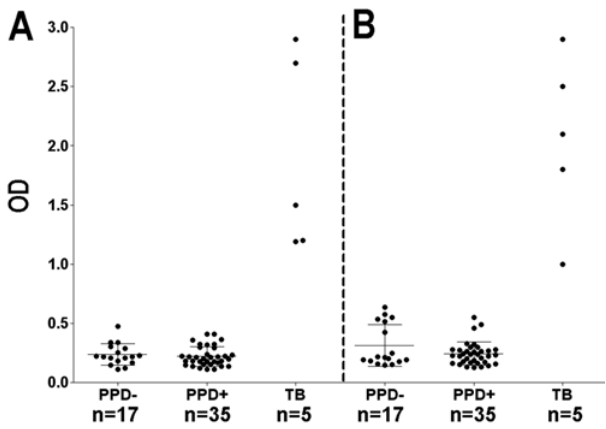
Figure 1. Reactivity of sera with MS and MPT51: Sera from HIV 2 PPD 2 and HIV 2 PPD + healthy subjects and TB patients were tested for reactivity with MS (A) and MPT51 (B). Mean OD (optical density) 6 standard deviation is